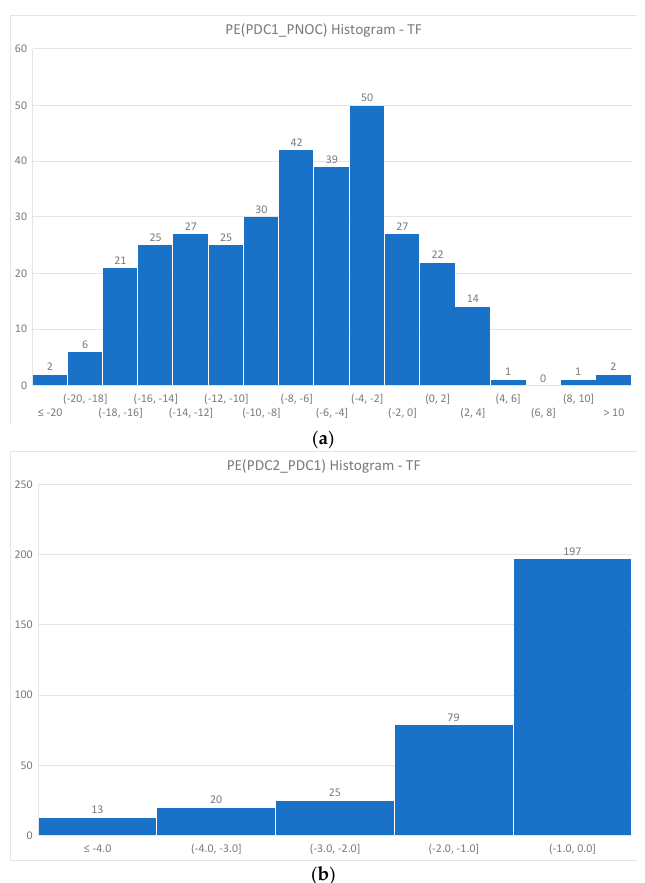
Figure 6. Histograms of the Percentage Error 𝑃𝐸 (cid:2869)(cid:3015)(cid:3016)(cid:3004) concerning 𝑃𝐷𝐶 (cid:2869)(cid:3015)(cid:3016)(cid:3004) and 𝑃 (cid:3015)(cid:3016)(cid:3004) ( a ), and the Percentage Error 𝑃𝐸 (cid:2870) (cid:3015)(cid:3016)(cid:3004) concerning 𝑃𝐷𝐶 (cid:2870) (cid:3015)(cid:3016)(cid:3004) and 𝑃𝐷𝐶 (cid:2869) (cid:3015)(cid:3016)(cid:3004) ( b ); thin-films modules.